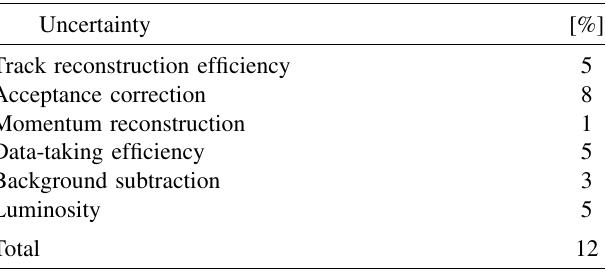
TABLE III. Systematic uncertainties in the measurement of the cross section for pp elastic scattering at T The total error has been obtained by adding the individual elements quadratically.